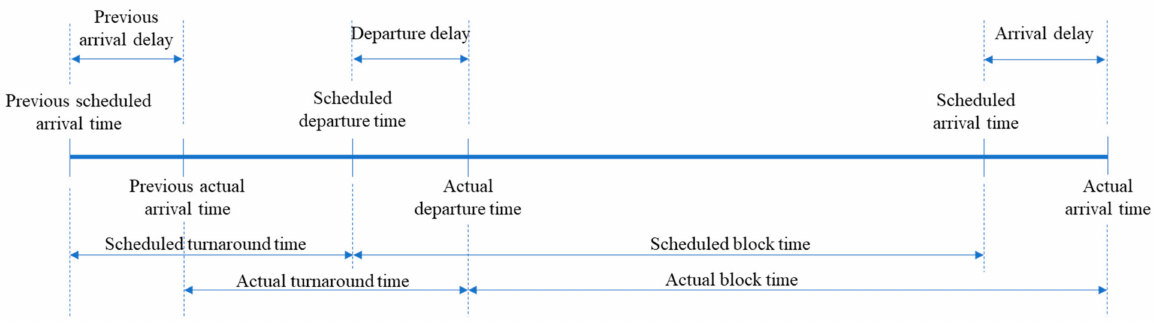
Figure 1. Time components related to a